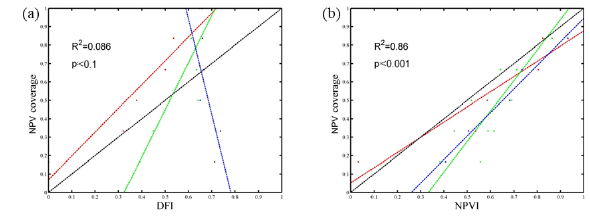
Fig.7 Relationship between NPV coverage and DFI (a), NPVI (b) in field experimental data. Red, green and blue respectively represent soil moisture of 11% ,16% and